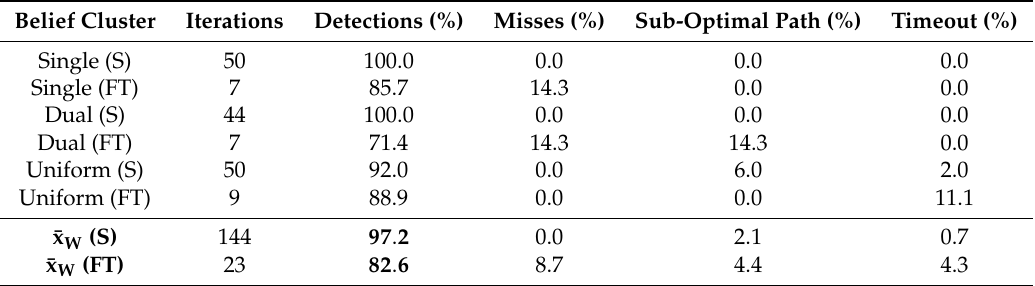
Table 3. Performance metrics for Hardware in the Loop (HIL) simulations (S) and real flight tests (FT), where ¯ x W is the weighted average of the measured